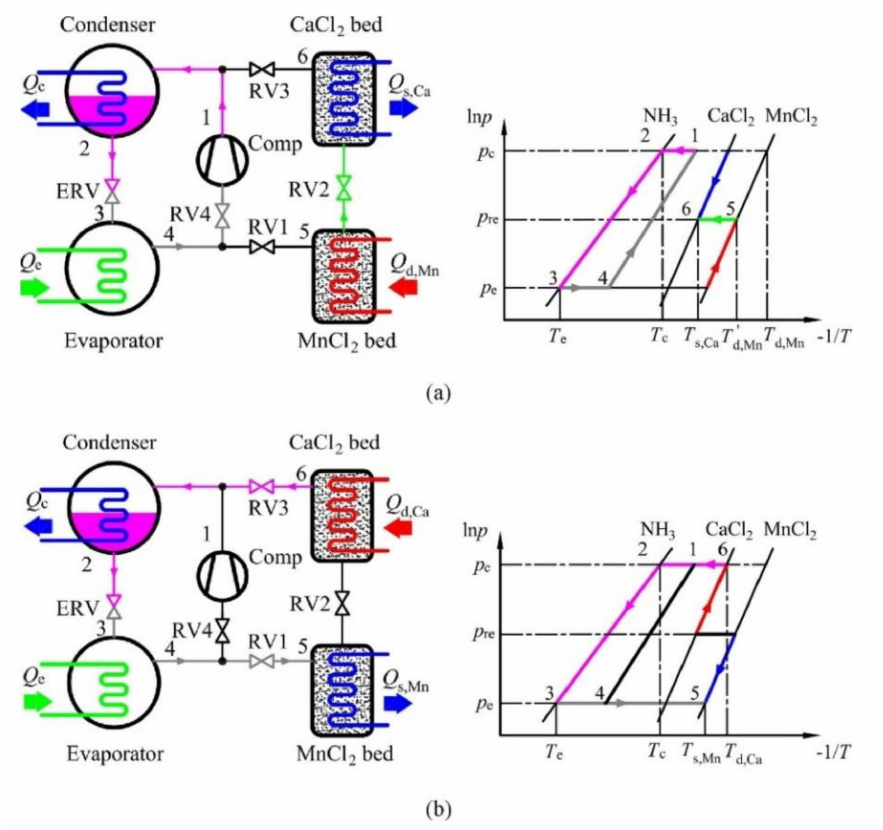
Figure 20. Schematic of the novel refrigeration cycle consisting of a vapor-compression cycle and thermochemical resorption energy storage unit: ( a ) Charging process; ( b ) Discharging process. Reprinted from ref. [51], Copyright (2021), with permission from